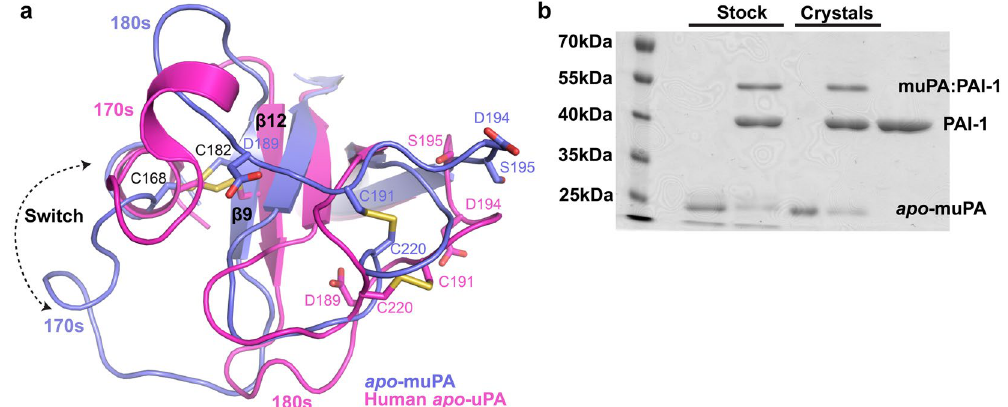
Figure 2. The antiparallel-to-parallel equilibrium. ( a ) Structural comparison of the C-terminal β -barrel between human apo- uPA (pink) and apo -muPA (blue) displaying the 180-degree switch of the β 9-strand. Key residues of the S1 specificity pocket (Asp189), the activation pocket (Asp194 and Ile16), and the Cys168-Cys182 and Cys191-Cys220 disulfide bridges are shown as sticks. ( b ) SDS-PAGE analysis of apo -muPA from the protein stock used for the crystallization experiments or from the washed and dissolved apo -muPA crystals in the absence or presence of